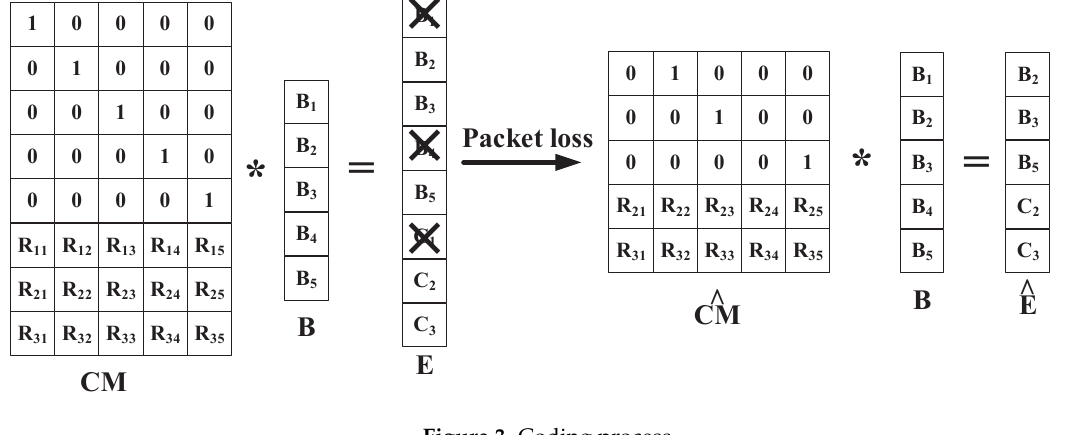
Figure 3. Coding